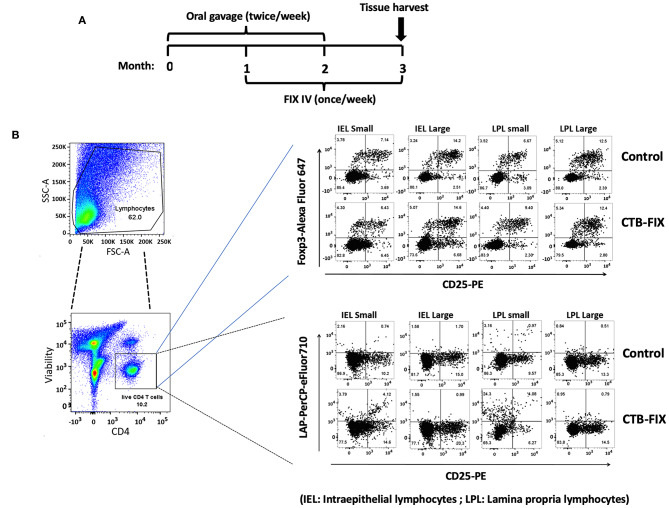
Analysis of Treg subsets in intraepithelial lymphocyte (IEL) and lamina propria lymphocyte (LPL) populations of small and large intestine of hemophilia B mice using flow cytometry. (A) Time course of oral tolerance regimen with CTB-FIX expressing plant cells and treatment by intravenous injection of recombinant FIX protein. (B) Gating scheme and examples of flow cytometry results. Examples of small intestine (“small”) and large intestine (“large”) results are shown for CD4+CD25+FoxP3+ T cells and CD4+CD25−LAP+ T cells. Control mice had not received any treatment.